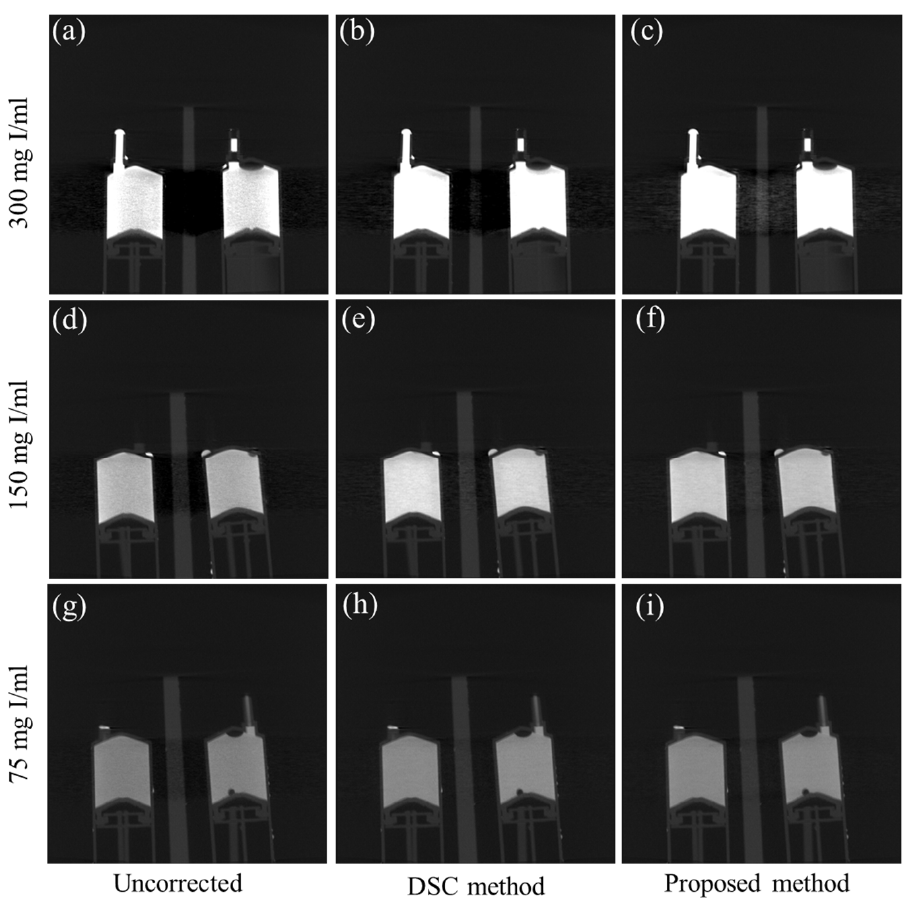
Figure 9. Examples of the beam hardening artifact reduction for the contrast agent phantom. The sagittal view images of the 300 mgI/mL phantom reconstructed from ( a ) the uncorrected projection data, and from the data corrected ( b ) by the original DSC method, and ( c ) by the proposed method, respectively. ( d – f ) The corresponding images of the 150 mgI/mL phantom. ( g – i ) The corresponding images of the 75 mgI/mL phantom. (Contrast window is [ − 1803~6972] in Hounsfield Unit).